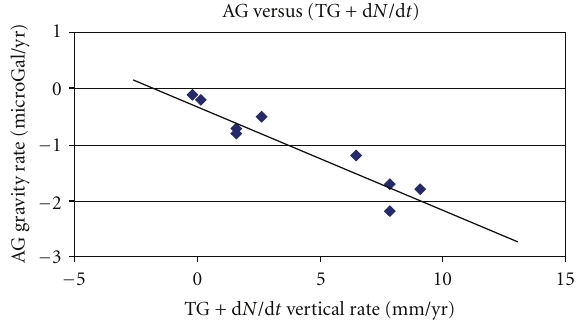
Figure 1: Linear regression between the gravity rate and the vertical uplift derived from tide gauges in Fennoscandia. See text for details.